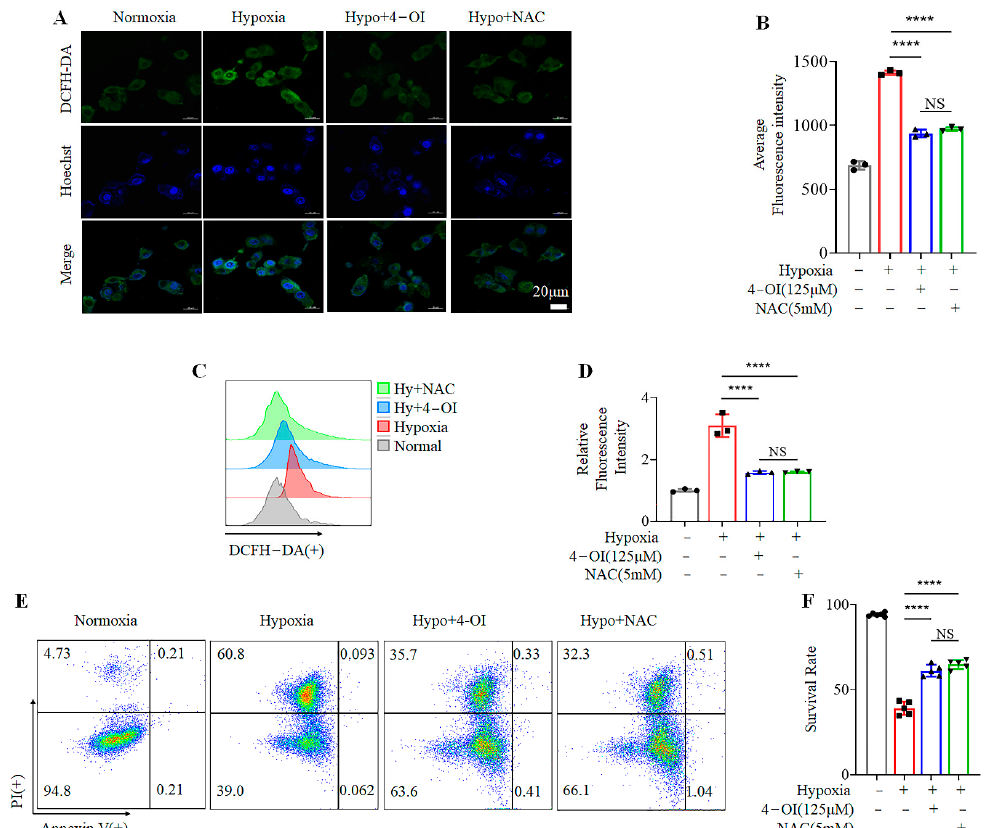
Figure 2. Treatment with 4-OI protects MIN6 cells from hypoxia by reducing ROS production: ( A , B ) ROS levels assessed by confocal microscopy in MIN6 cells after 4-OI or NAC treatment under hypoxia ( A ), and their quantification ( B ). ( C , D ) FACS results showing reduced ROS levels after the addition of 4-OI or NAC to cells ( C ), and their quantification ( D ). In FACS, more displacement on the horizontal axis indicates more positive ROS staining. ( E , F ) Survival rates of MIN6 cells treated with 4-OI or NAC under hypoxia measured with FACS ( E ), and their quantification ( F ). Error bars represent the mean ± SD. One-way ANOVA was performed with **** p < 0.00005, NS: non-significant.